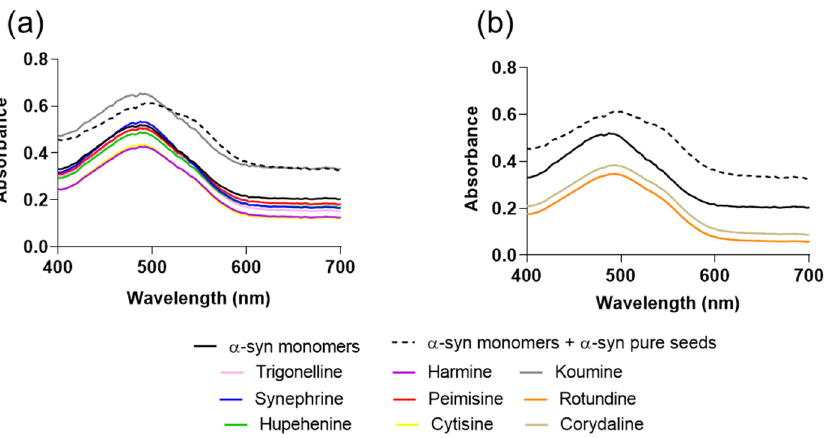
Figure 3. Congo red (CR) absorbance spectra in the presence of alkaloid compounds ( a , b ). Means ± standard deviations are from triplicates of one experiment.